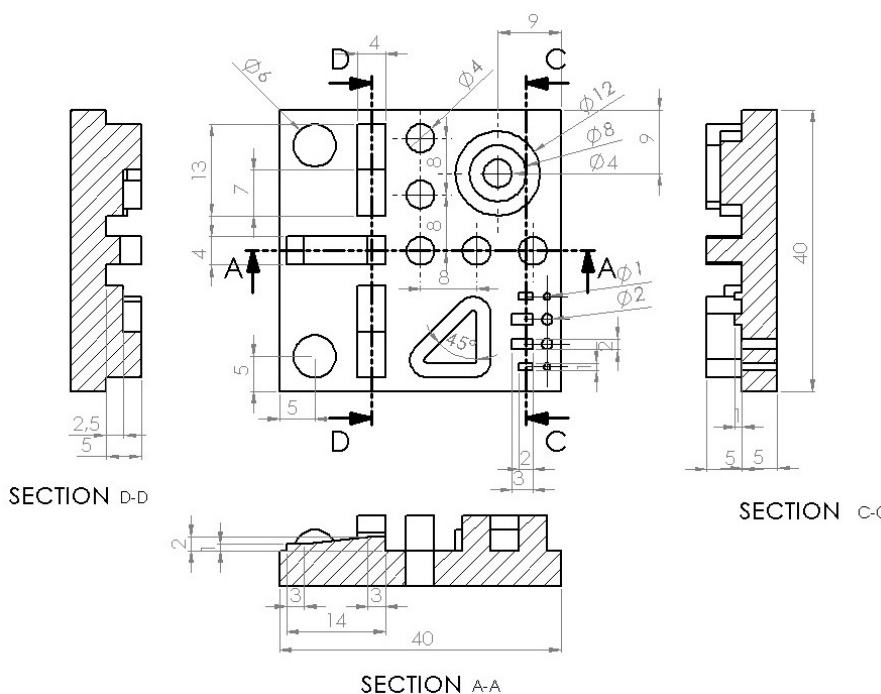
Figure A1. N ew artifact model with dimensions, in mm Figure A1. New artifact model with dimensions, in mm.